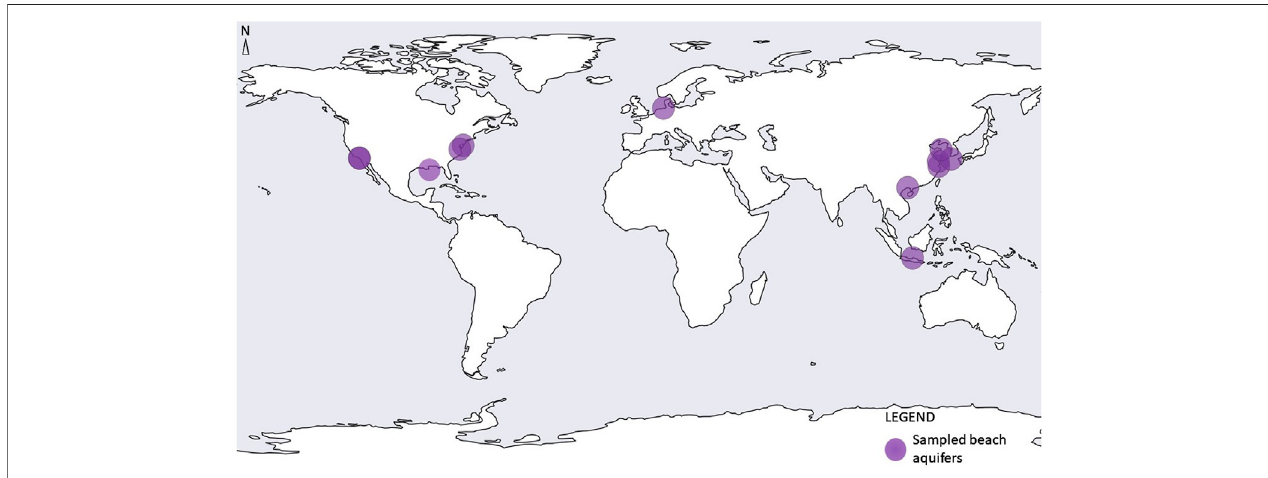
FIGURE 2 | Geographic locations of globally sampled beach aquifers. Note - some dots overlap with others (Sources: Santoro et al., 2006; Santoro et al., 2008; McAllister et al., 2015; Ye et al., 2016; Lee et al., 2017; Adyasari et al., 2019; Chen et al., 2019; Jiang et al., 2020; Chen et al., 2020; Adyasari et al., 2020; Degenhardt et al., 2020, Hong et al.,